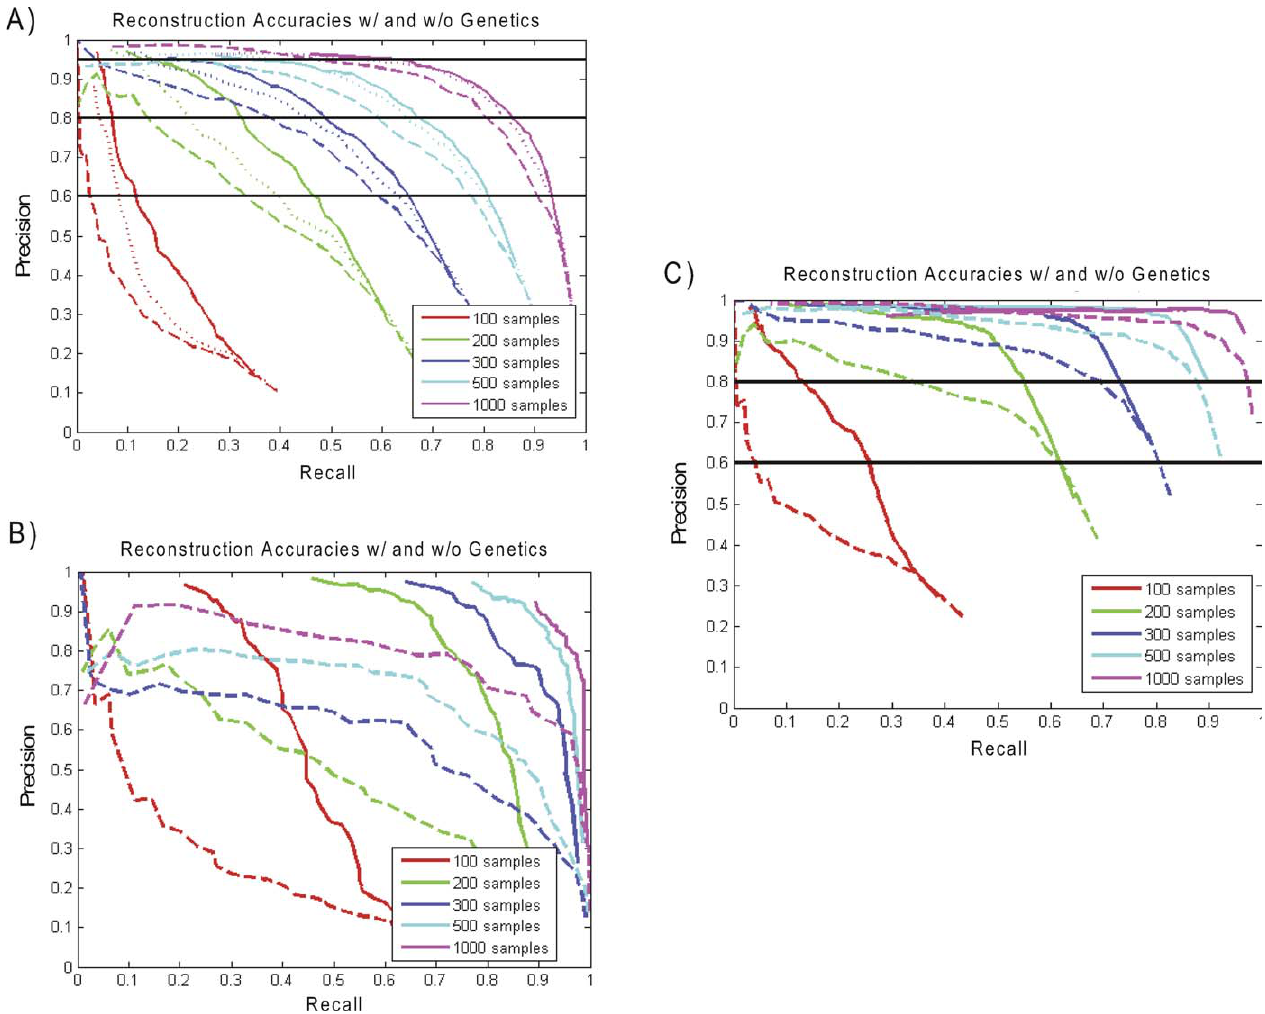
Figure 5. Reconstruction accuracy with the genetic (dotted and solid lines, as described in the Figure 4 legend) and without the genetic (dashed lines) information, using varying numbers of samples, and based on reduced heritability and a weak overall correlation structure compared with what we observed in the BXD network (see text for details) (A) Accuracies of networks reconstructed with and without genetic information. (B) Accuracies of subnetworks consisting only of those nodes in the top layer of the network. (C) Accuracies of networks in which a true edge was counted as correct if the corresponding nodes were connected either directly or by a path involving two edges in the reconstructed network. It is clear the genetic data significantly enhance reconstruction